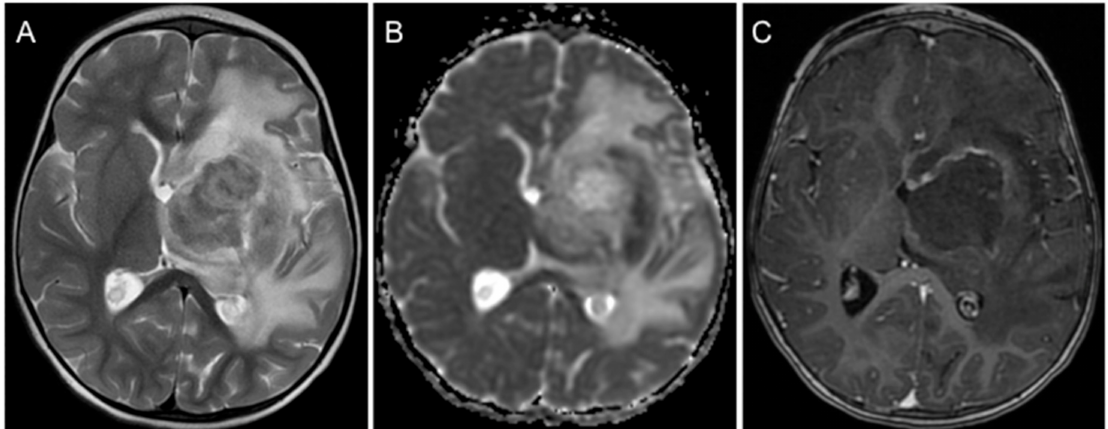
Figure 1. Imaging features of primary central nervous system lymphoma. ( A ) An axial T2-weighted magnetic resonance image shows a large left-sided mass primarily located in the basal ganglia/thalamus with considerable perifocal edema. ( B ) Diffusion-weighted imaging (apparent diffusion coefficient map) demonstrates diffusion restriction in the periphery of the tumor, indicating high cellularity. ( C ) Following intravenous contrast medium administration, relatively little inhomogeneous enhancement is seen at the margins of the